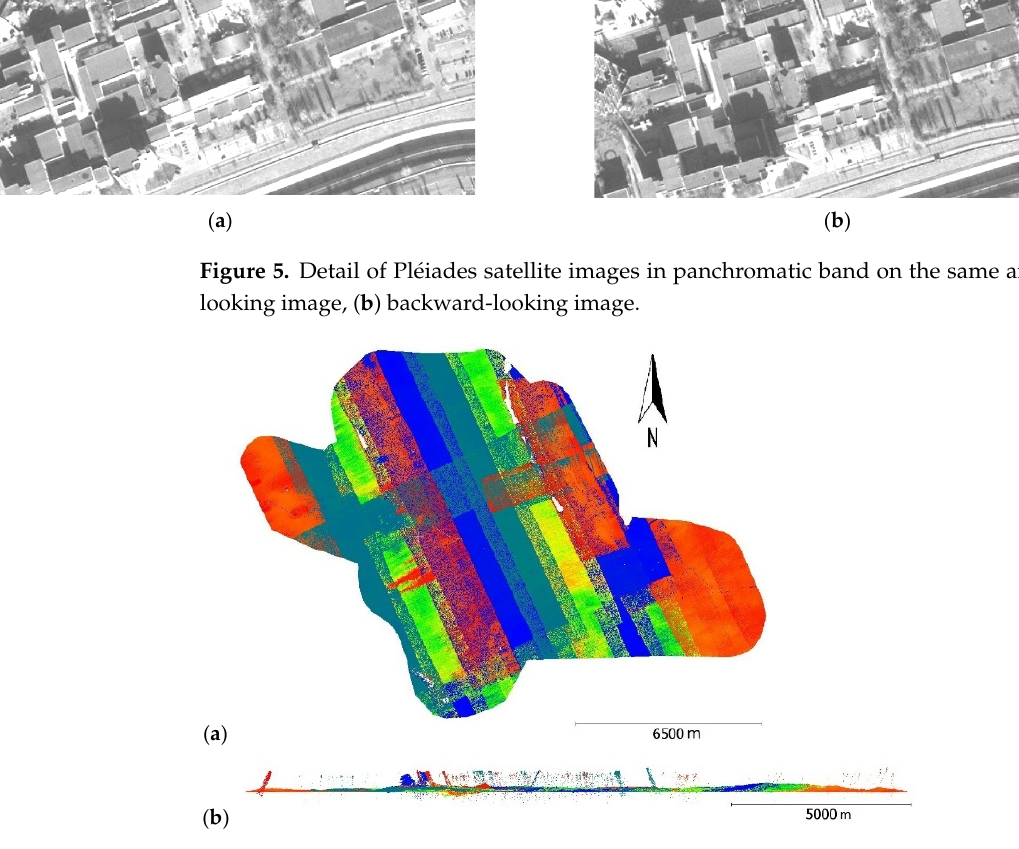
Figure 6. The LR ALS original strips along the Iasi city area: ( a ) top view; ( b ) front view.